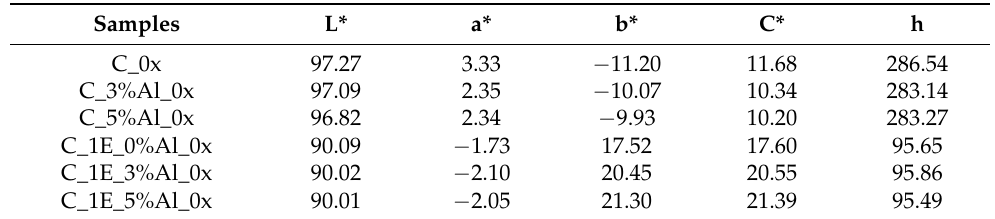
Table 3. Color coordinates of cotton samples dyed with SJL aqueous extract with and without mordants before washing.